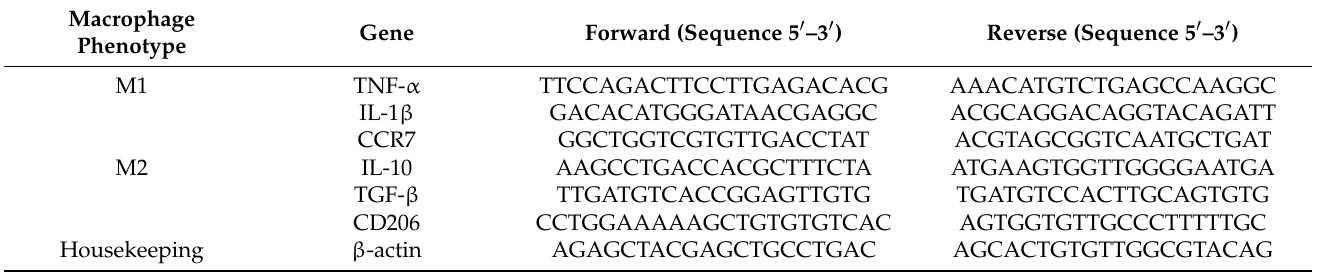
Table 1. Primer sequences for